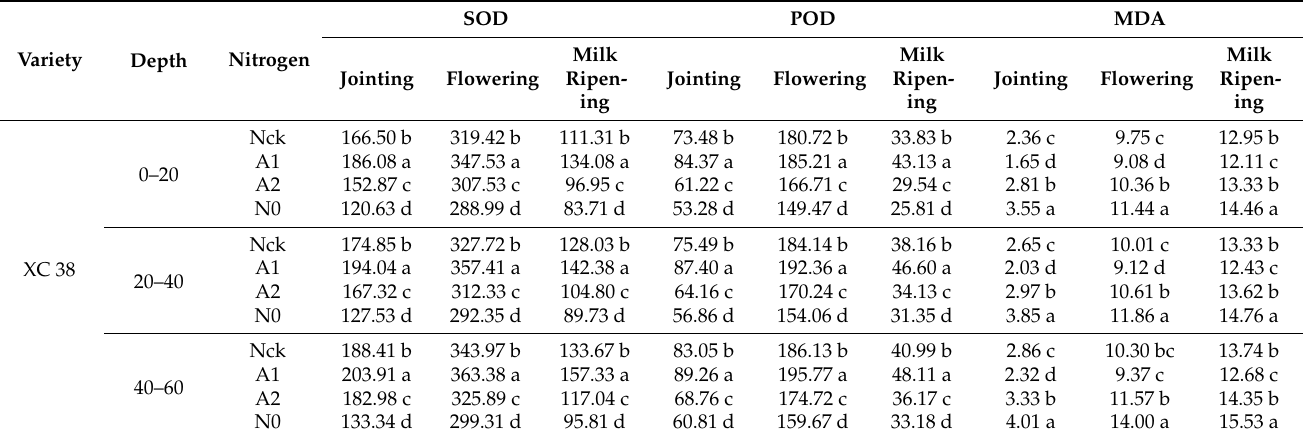
Table 3. Effect of different nitrogen application rates on root antioxidant enzymes activity and MDA content of drip-irrigated spring wheat in 2019.